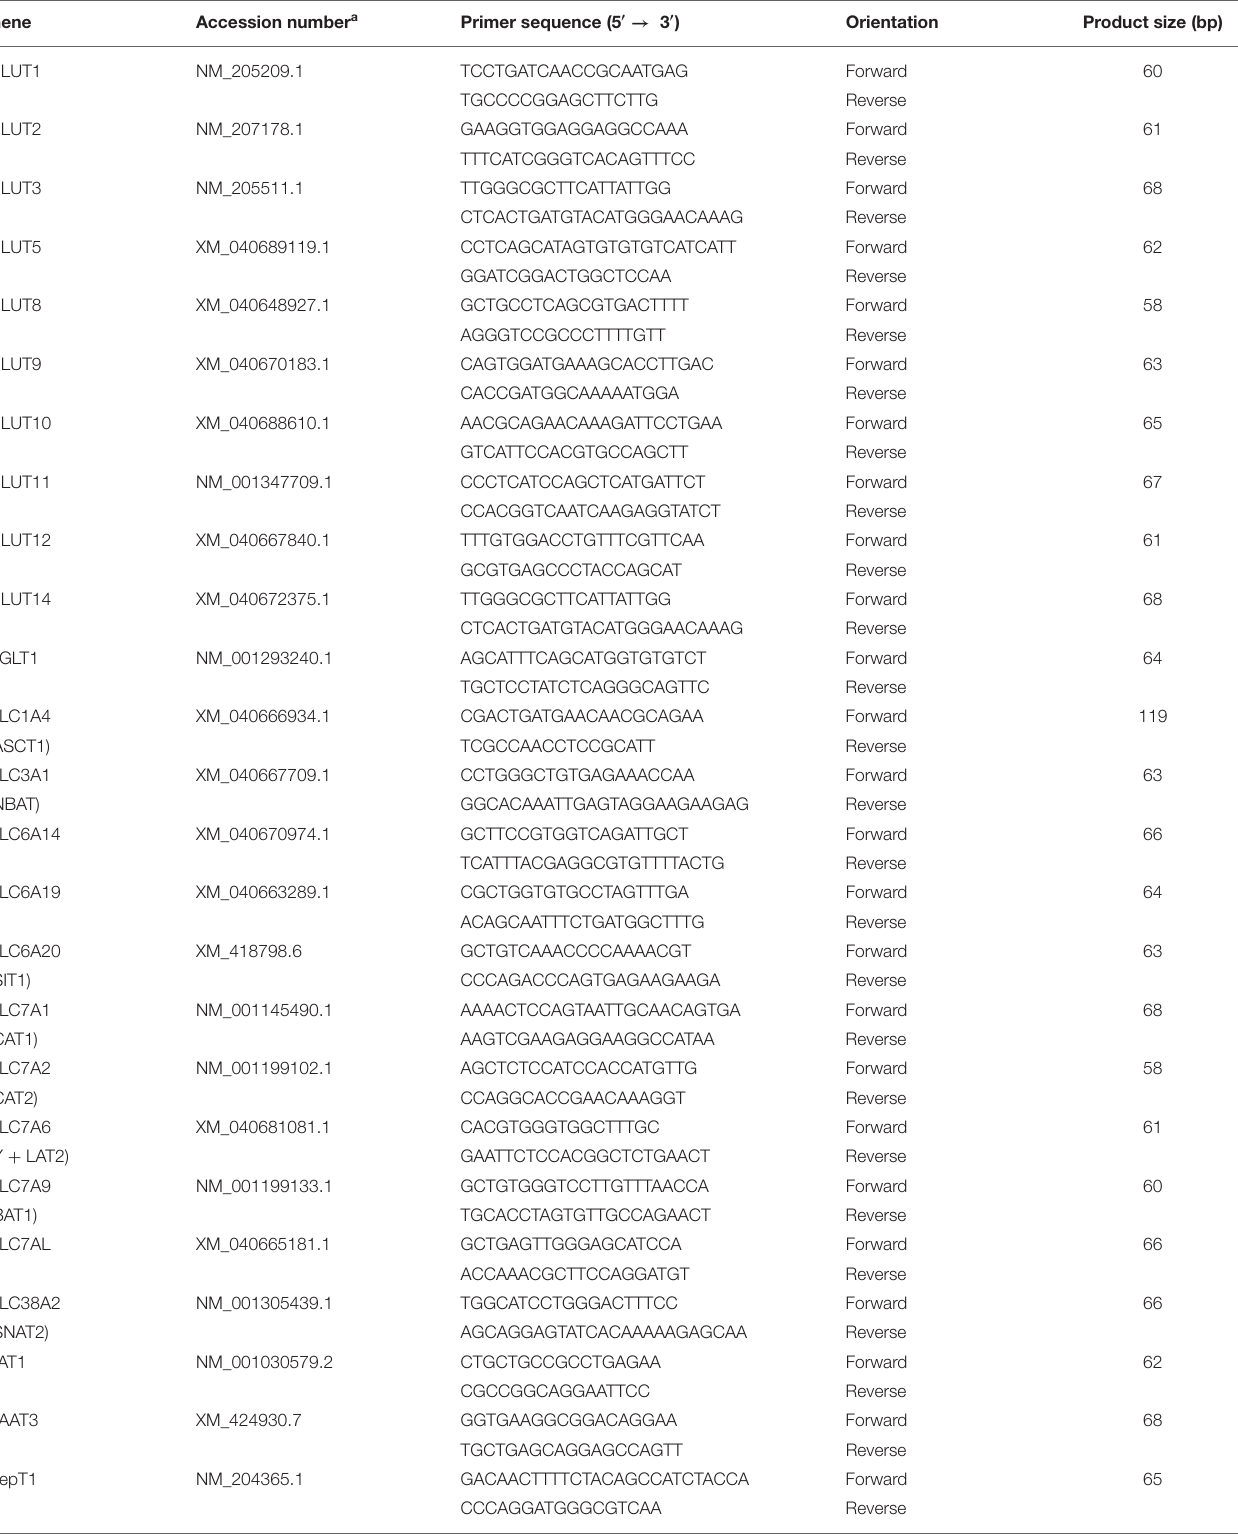
TABLE 1 | Oligonucleotide real-time qPCR